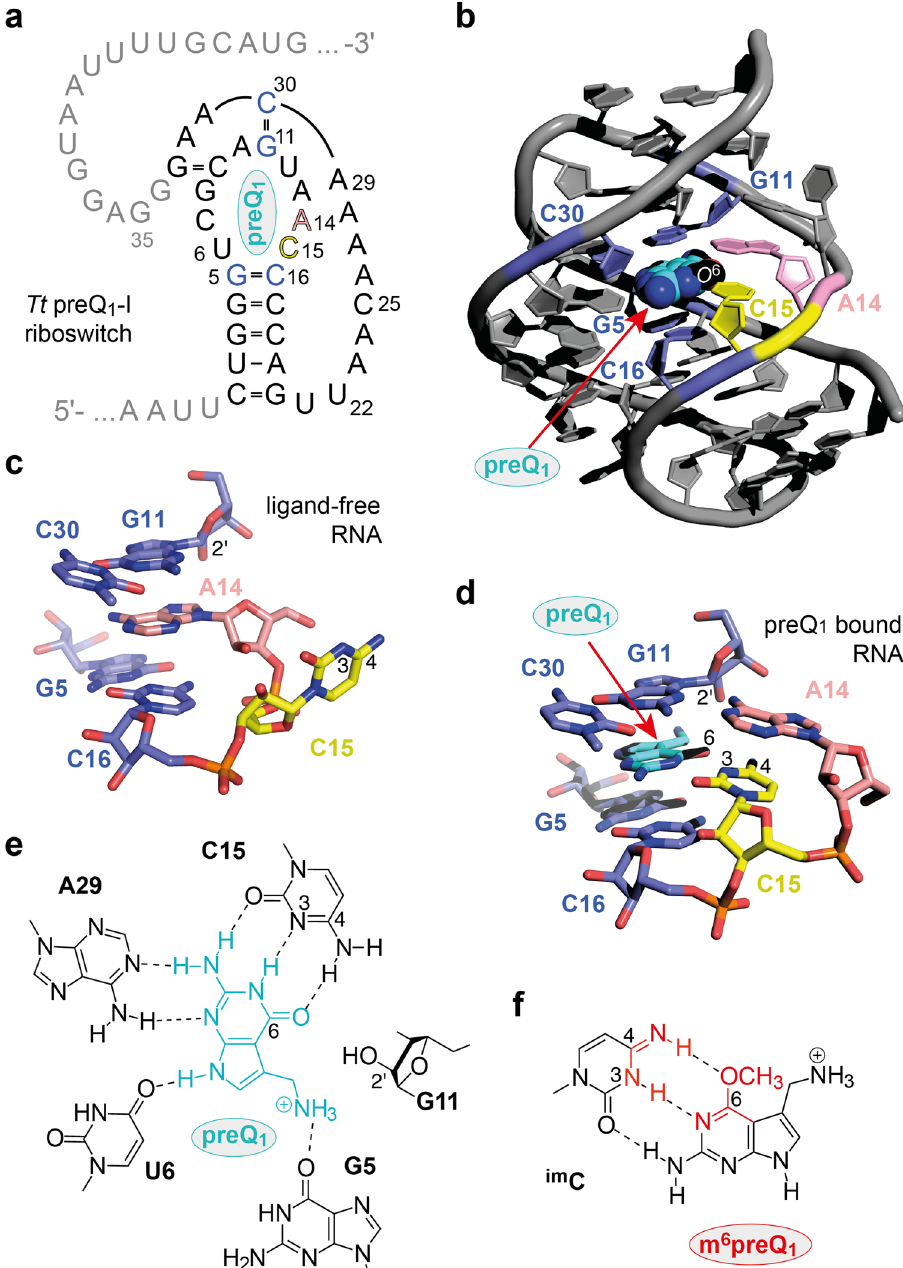
Fig. 2 Analysis of preQ 1 -I riboswitch structures in the light of reactivity prediction. a Sequence and secondary structure of the Tt preQ 1 -I riboswitch (minimal aptamer motif in black). b Cartoon representation of the three-dimensional fold of the preQ 1 -bound aptamer (pdb code 3Q50; DOI: 10.2210/ pdb3q50/pdb). c Stick representation of the ligand-free pocket revealing that A14 slides into the pocket and fi lls the space of preQ 1 while C15 fl ips out and becomes exposed (pdb code 3Q51; DOI: 10.2210/pdb3q51/pdb). d Stick representation of the preQ 1 -bound riboswitch pocket with crucial atom numbers annotated in black. e Chemical structures illustrating the hydrogen bond network of preQ 1 in the riboswitch pocket and the 2 ’ -OH group of G11 that comes close the Hoogsteen face of preQ 1 . f Structure of a putative base pair between C15 (imino tautomer) and m 6 preQ 1 in the preQ 1 -I riboswitch